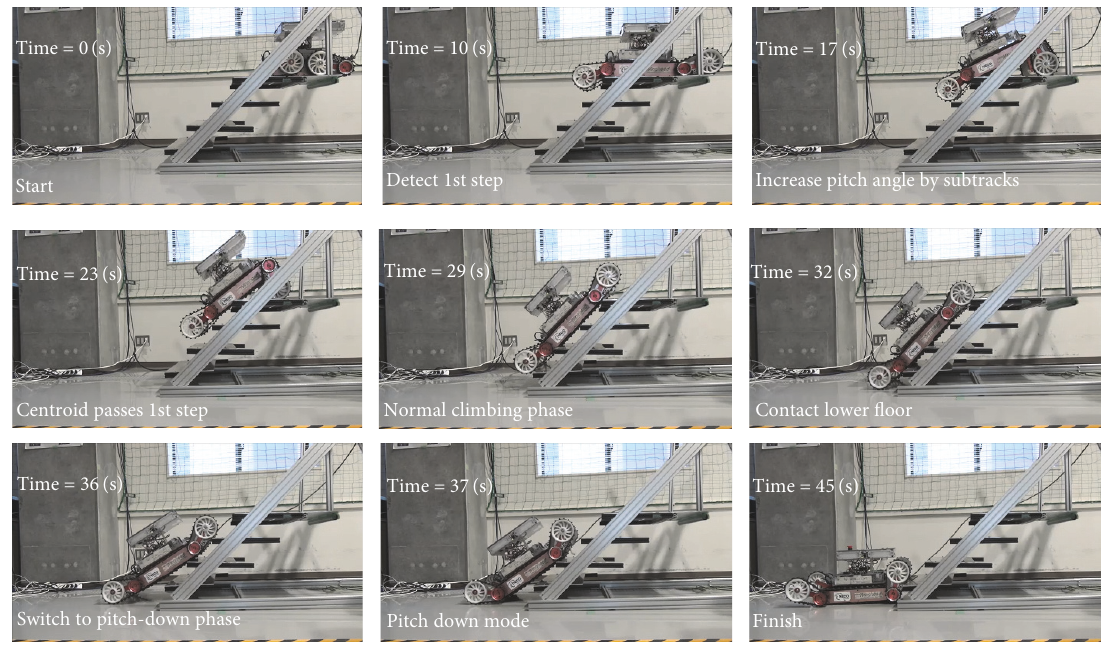
Figure 23: Climbing-down behavior for case 𝜃 𝑠 = 45 ∘ , 𝑝 = 200 mm.